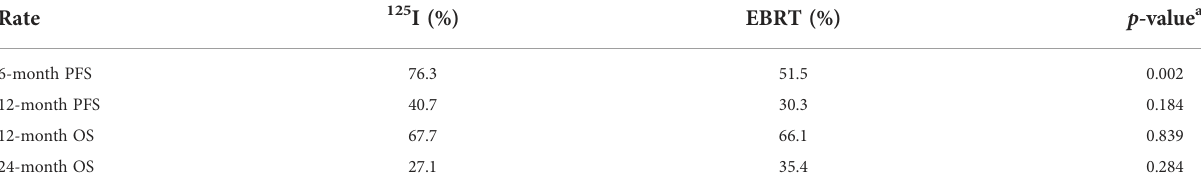
TABLE 2 PFS and OS control rate at different time